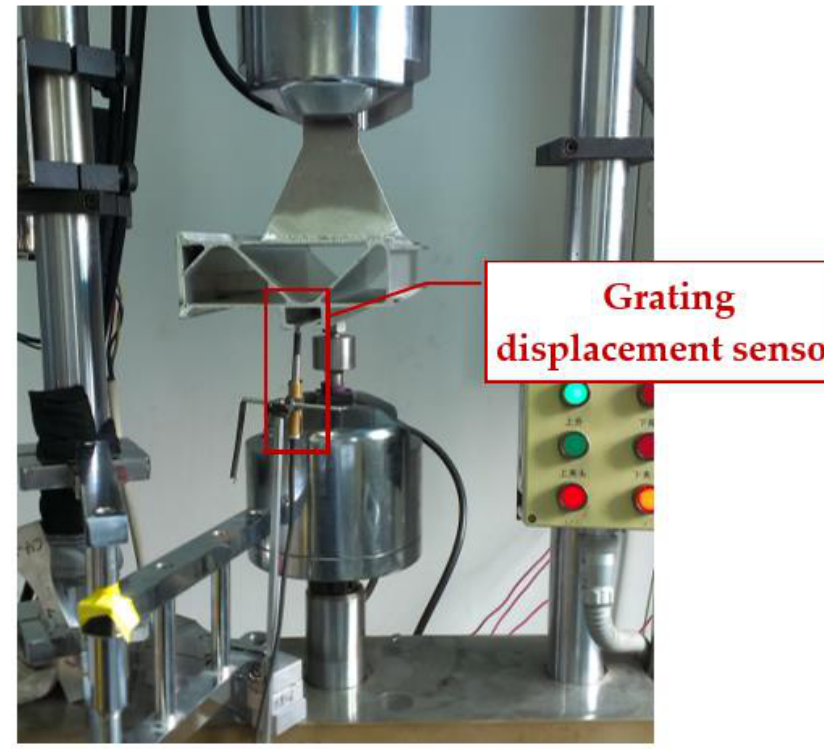
Materials 2023 , 16 , x FOR PEER REVIEW Figure 8. Test structure component and loading system. Figure 8. Test structure component and loading system.